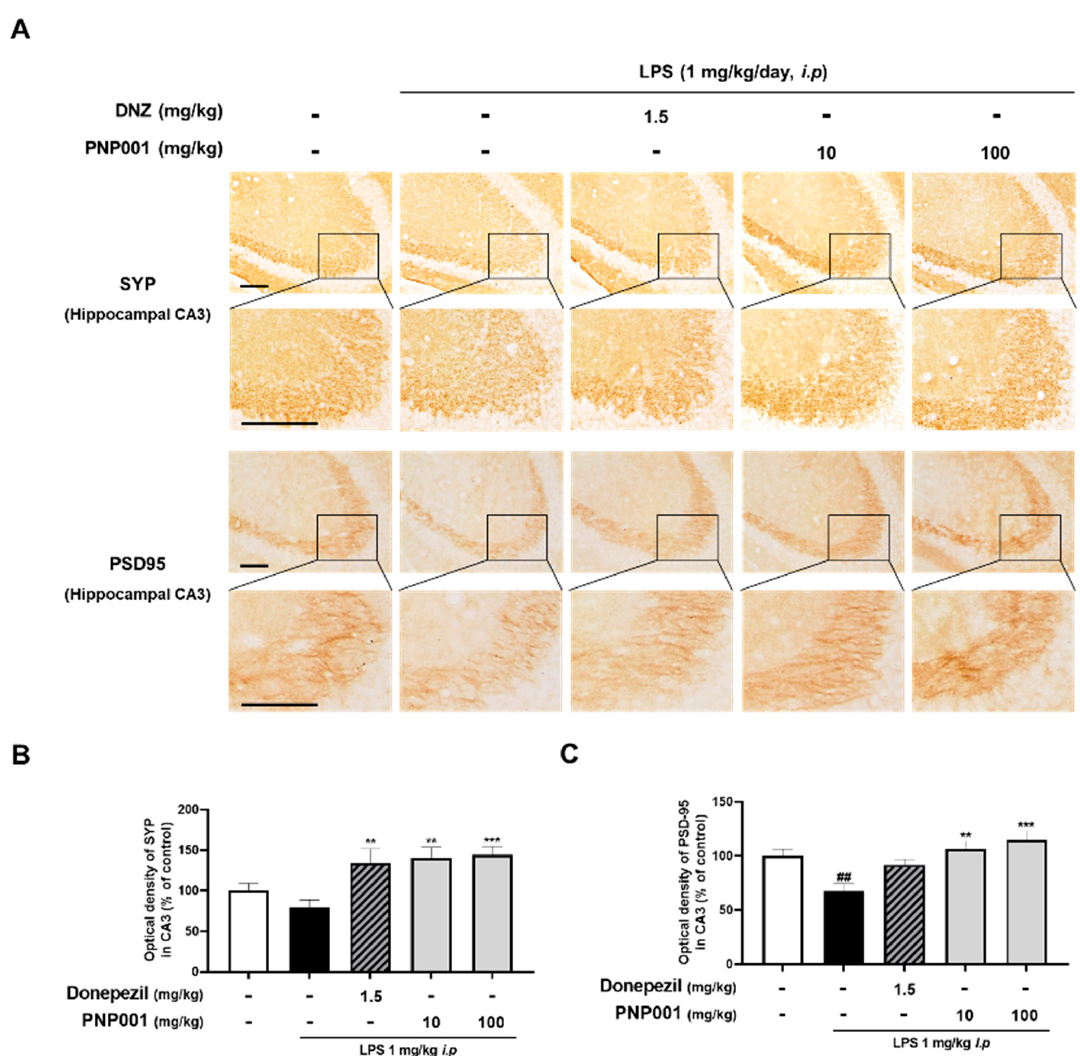
Figure 5. Effects of PNP001 on synapse loss in hippocampal CA3 striatum lucidum (SL) of LPS- injected mice. Mice were administered with PNP001 (10 or 100 mg/kg, p.o. ) and DNZ (1.5 mg/kg, p.o. ) for 18 consecutive days, and LPS (1 mg/kg, i.p. ) was administered concurrently for 10 days from the 4th day of PNP001 administration. Representative images ( A ) and quantifications ( B , C ) for the immunoreactive region of synaptophysin (SYP) and post-synaptic density protein-95 (PSD-95) in the hippocampal CA3 SL are shown. Scale bar = 100 μ m ( n = 4~5 per group). Values are indicated as the mean ± S.E.M. Data were analyzed by two-way ANOVA, followed by Tukey’s multiple com- parisons test. ## p < 0.01 compared to the control group; ** p < 0.01 and *** p < 0.001 compared to the LPS-only-injected group.